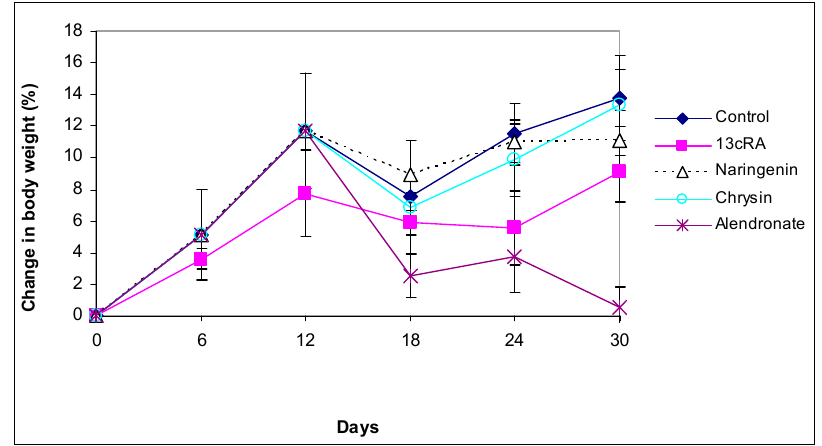
Figure 1. Effect of naringenin, chrysin, or alendronate on the body weight changes in rats with retinoic-acid-induced osteoporosis. Rats were administered ig with retinoic acid (13cRA) suspension (80 mg/kg) once daily for 14 days. After inducing osteoporosis with 13cRA, rats were administered ig with naringenin (100 mg/kg), chrysin (100 mg/kg), or alendronate (40 mg/kg), once daily for the next 14 days. Body weight changes (%) were calculated as follows: percentage change in weight = (final weight − initial weight) × 100/final weight. Number of rats per group: 7.